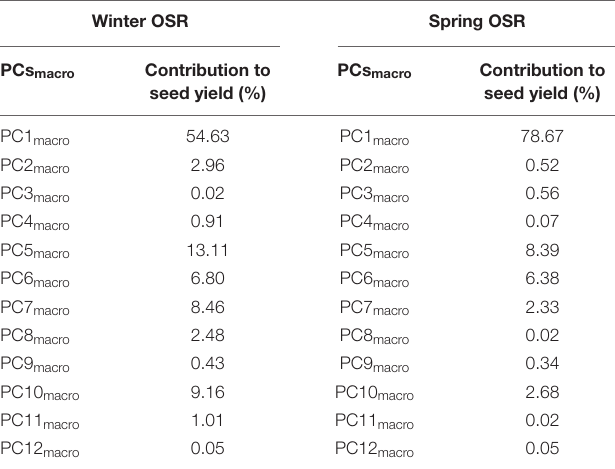
TABLE 2 | Principal component (PC) contribution to seed yield as a percentage of total variation explained from all PCs for Winter OSR and Spring OSR [expressed as contribution to seed yield (%)] for